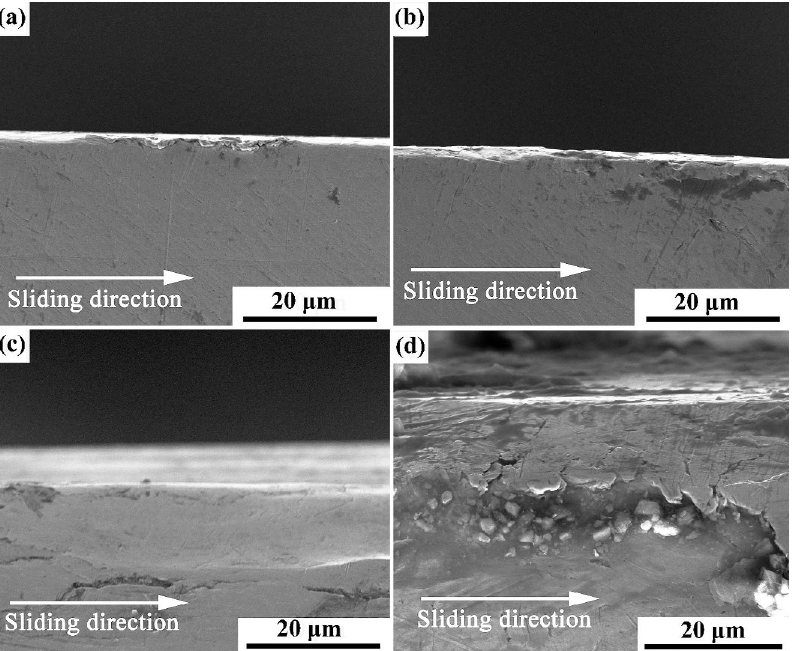
Fig. 13 SEM images of the cross-sections of Cu–15Ni–8Sn–0.8Nb alloy under different sliding conditions: (a) 50 N, 0.13 m/s; (b) 50 N, 2.58 m/s; (c) 700 N, 0.13 m/s; and (d) 700 N, 2.58